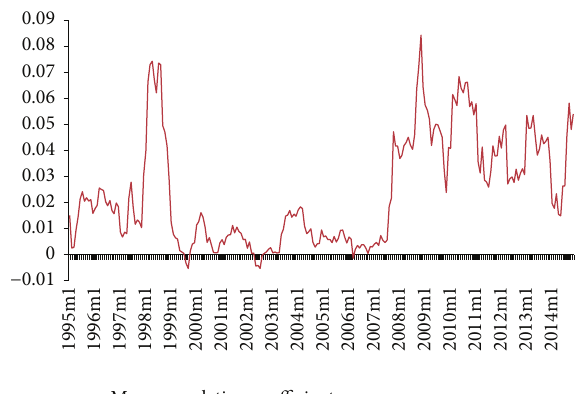
Figure 3: Correlation coefficient as a function of 𝑇 . We used time windows of 𝑇 = 12 months and window step length parameter Δ𝑇 = 1 month.